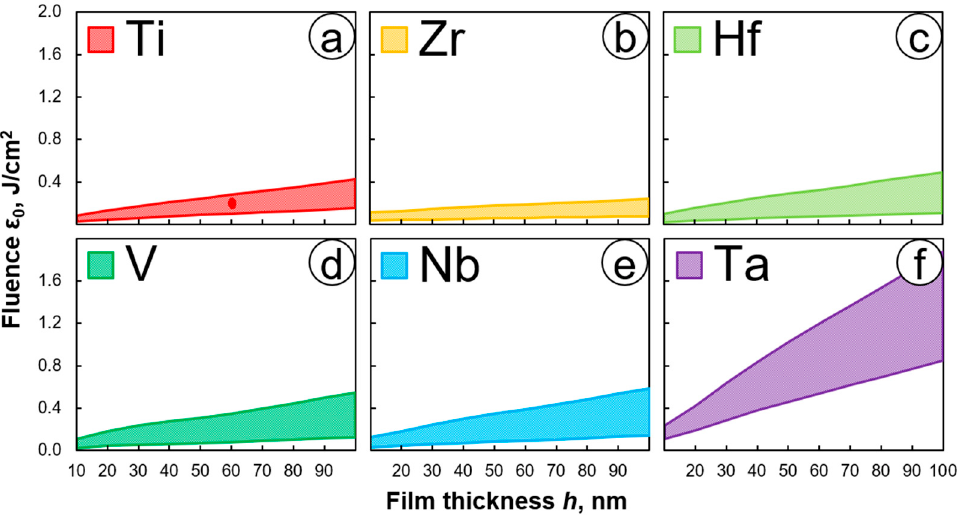
Figure 3. Estimated ranges of laser fluence for different film thicknesses and different materials: ( a ) titanium Ti, ( b ) zirconium Zr, ( c ) hafnium Hf, ( d ) vanadium V, ( e ) niobium Nb, ( f ) tantalum Ta. The red dot at the Ti diagram shows the area of thermochemical recording experimentally defined in [29,34] .